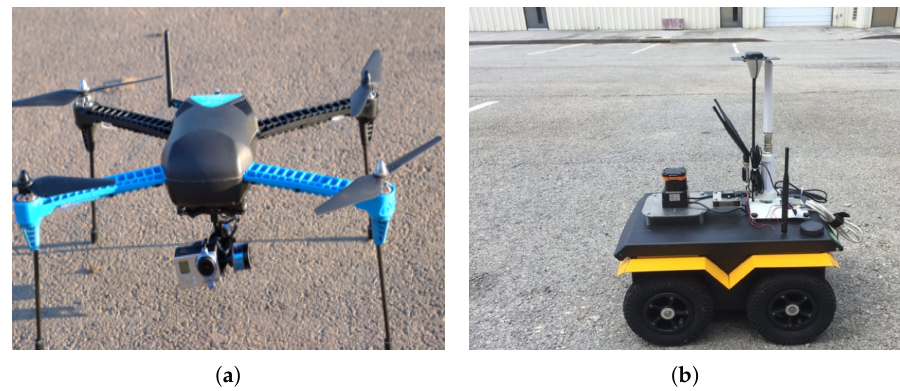
Figure 3. Images of data collection hardware: ( a ) Image of unmanned aerial vechile (UAV), 3DR Iris quadrotor, on ground before takeoff [35]. ( b ) Image of unmanned ground vehicle, Jackal by Clearpath